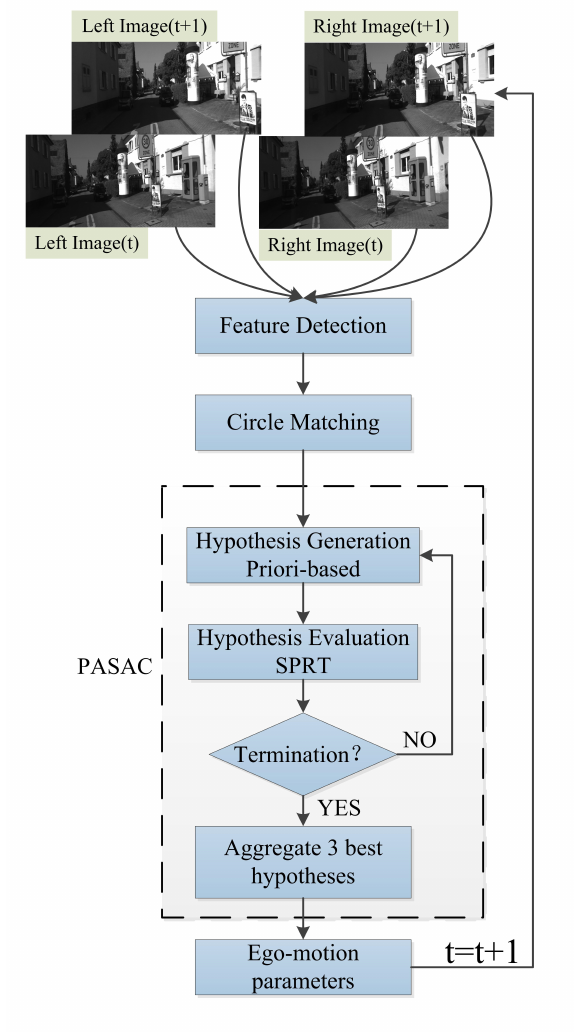
Figure 1. Algorithm architecture, camera images are from the KITTI dataset. The dash rectangle is our robust motion estimation method